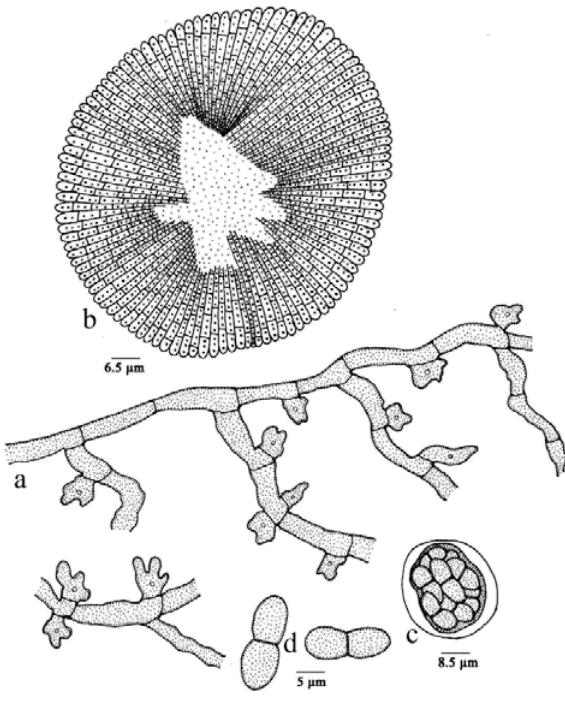
Figure 130. Asterina adeniicola a - Appressorium; b - Thyriothecium; c - Ascus; d -